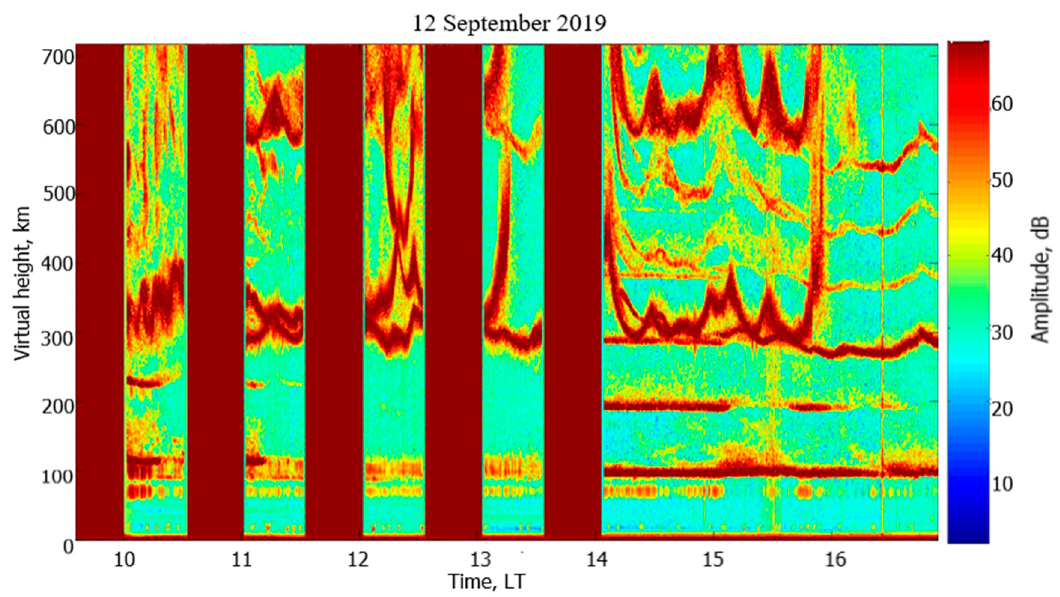
Figure 4. The virtual height-time dependence of the scattered-signal amplitude in 12 September 2019.